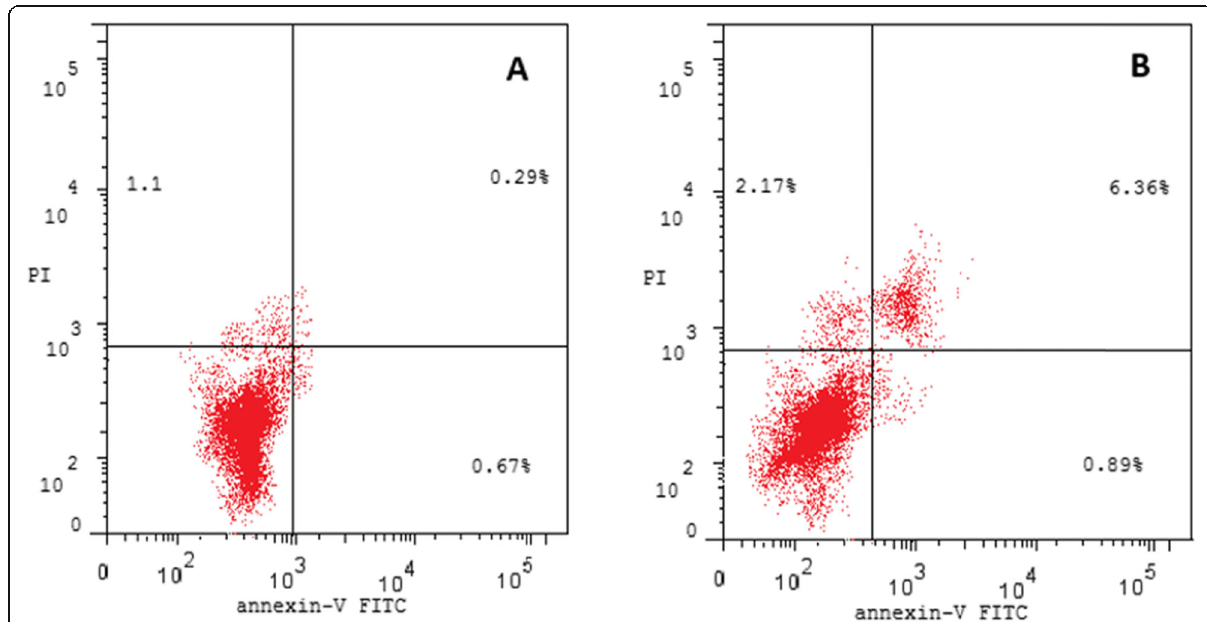
Fig. 2 Annexin V/PI double-staining assay of control SCC-25 ( a ) and SCC-25 cell lines treated with artichoke extract at 48 h. The Y -axis represents the PI-labeled population, whereas the X -axis represents the labeled annexin-V FITC-positive cells. The lower left portion of the fluoro-cytogram (An-, PI-) shows viable cells, whereas the lower right portion (An+, PI-) shows early apoptotic cells. The upper right portion (An+, PI+) shows late apoptotic cells, while the upper left portion (An-/PI+) demonstrates the percentage of necrotic cells